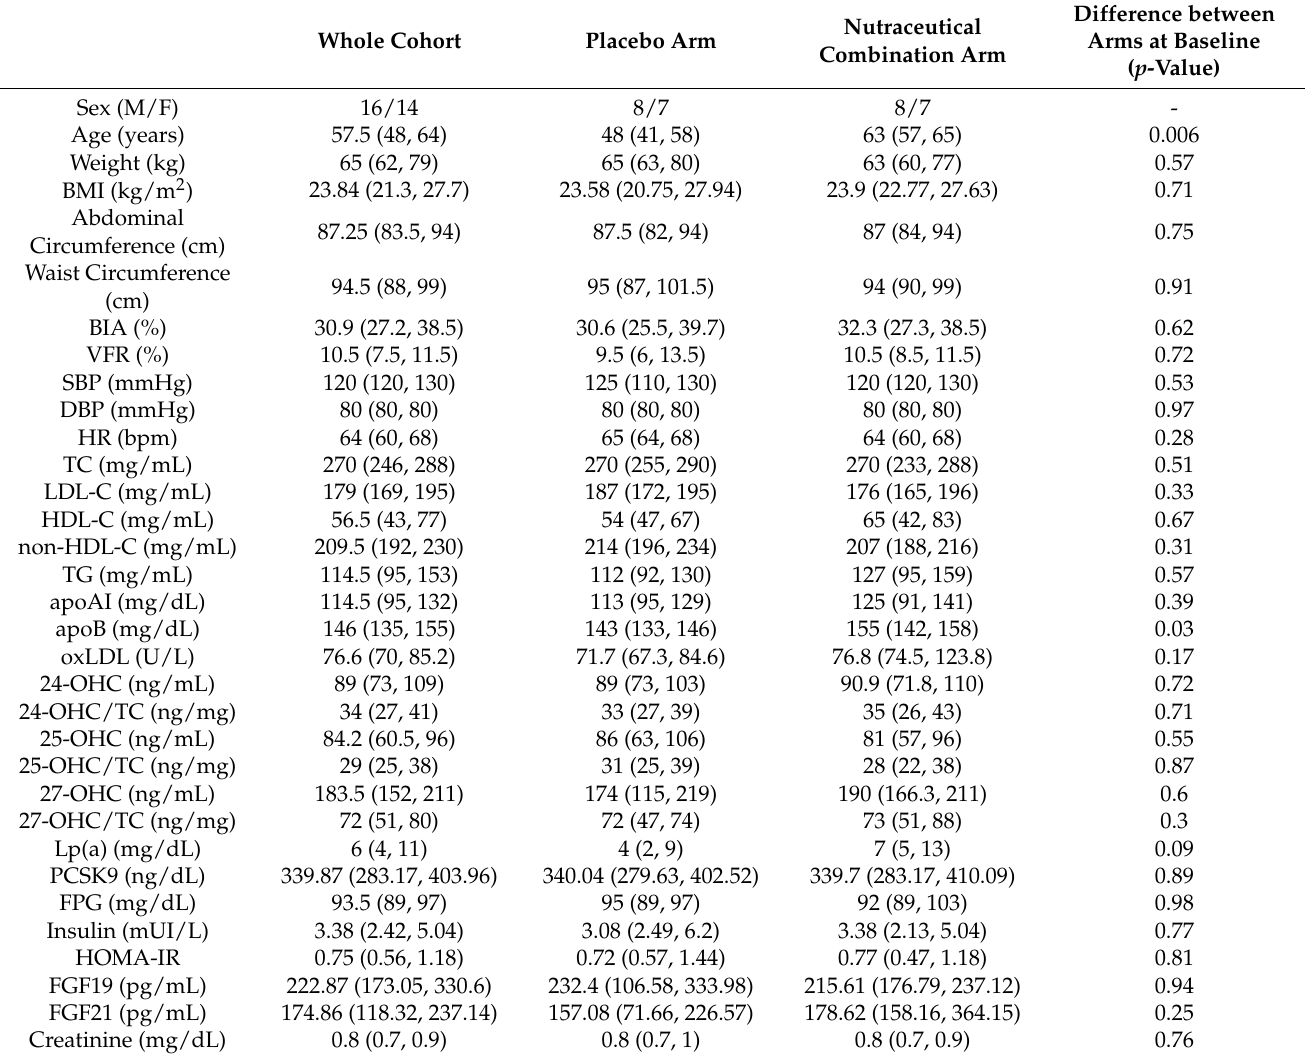
Table 1. Main clinical and biochemical characteristics of the whole study population and sorted in the two arms. Whole Cohort Placebo Arm